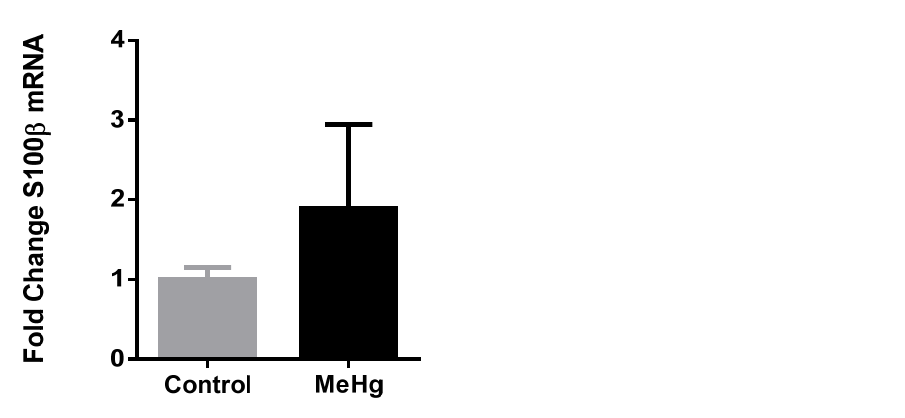
Figure 5. S100 β mRNA in circulating plasma EVs cargo. Rats exposed to MeHg 5 mg/kg for four consecutive days presented no significant change in S100 β mRNA in EVs cargo. Results are expressed as mean ± SEM. n = 4–5 per group. Student t test p > 0.05.